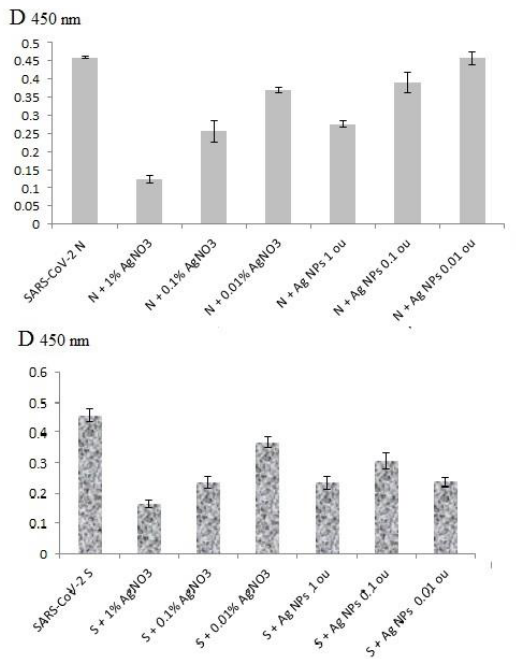
Figure 5. ELISA data for SARS-CoV-2 recombinant antigens N and S2 after their preliminary treatment with different concentrations of AgNO 3 and Ag